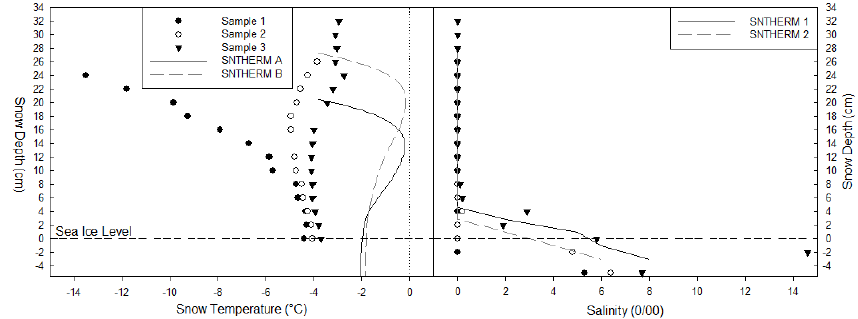
Figure 9. In situ sampled (1, 2, 3) and SNTHERM simulated snow temperature values. In situ sampled (1, 2, 3) salinity values, with the typical (SNTHERM 1) and lower in situ (SNTHERM 2) salinity values applied to the snow profiles input to the MSIB.